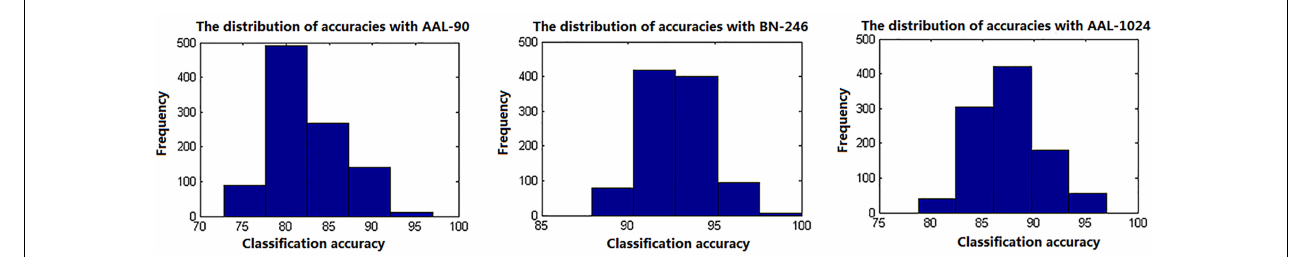
FIGURE 7 | The classification accuracies distributions of the permutation test with three different